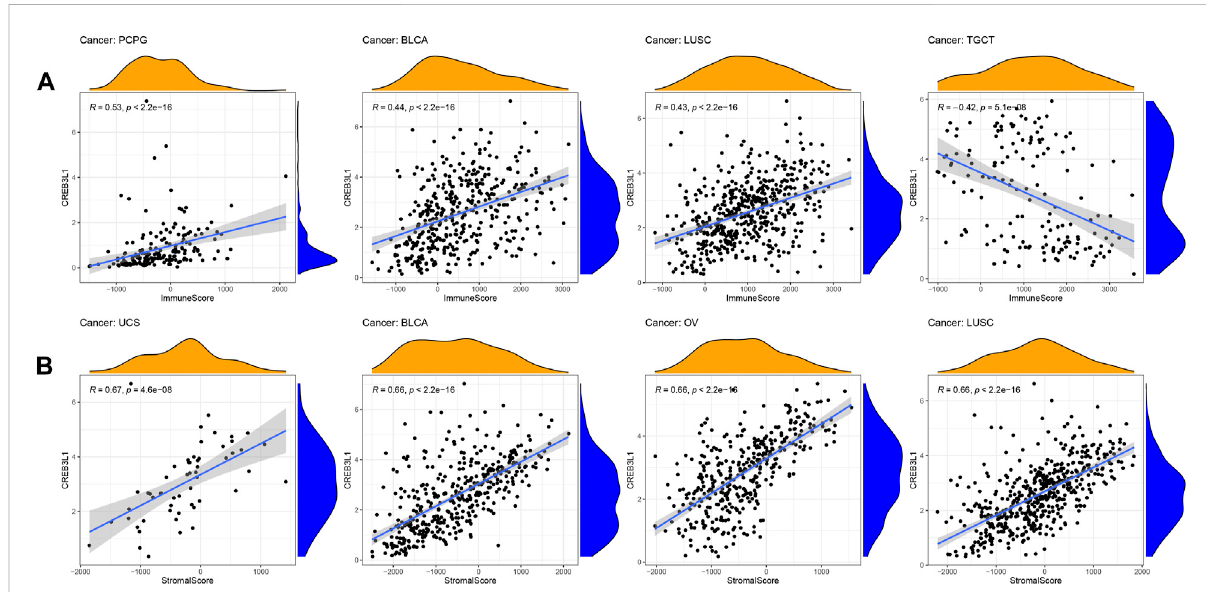
FIGURE 5 The correlation between CREB3L1 and immune and stromal scores in pan-cancer. (A) The association between CREB3L1 expression and immunescoreinPCPG,BLCA,LUSC,andTGCT. (B) TheassociationbetweenCREB3L1expressionandstromalscoreintop4cancertypes,including UCS, BLCA, OV, and